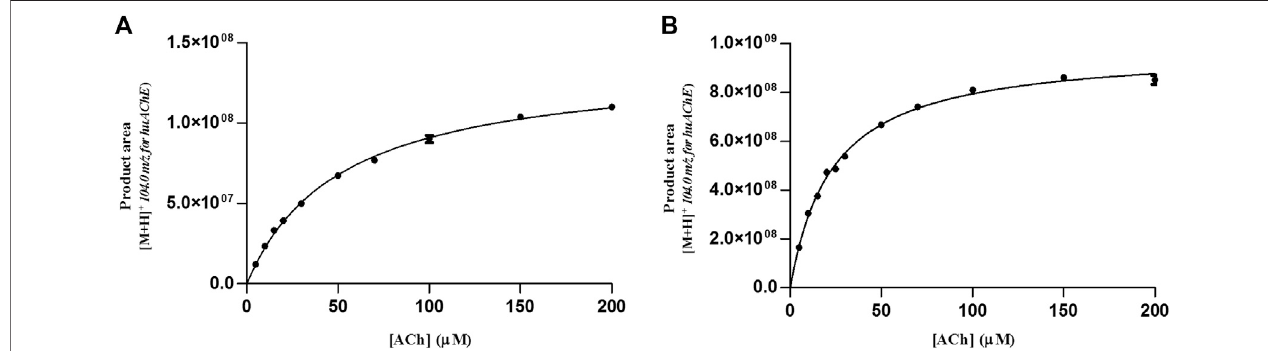
FIGURE 3 | Michaelis-plots of the product area obtained for huAChE-ICER by using ACh as the substrate. (A) mobile phase pH 4.5 and (B) mobile phase pH 8.0. See Table 1 for conditions.